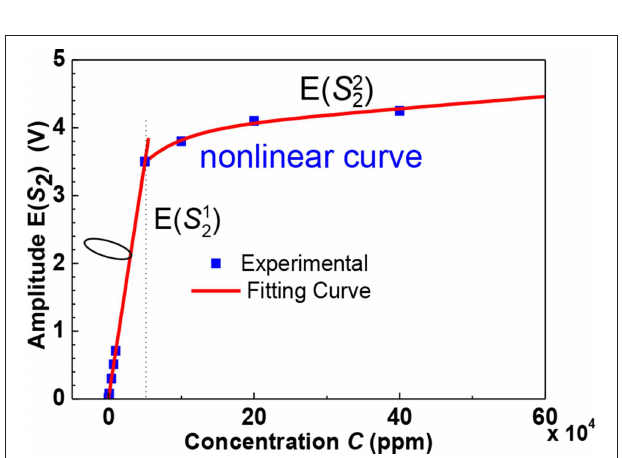
FIGURE 12 | Calibration experiment of CO 2